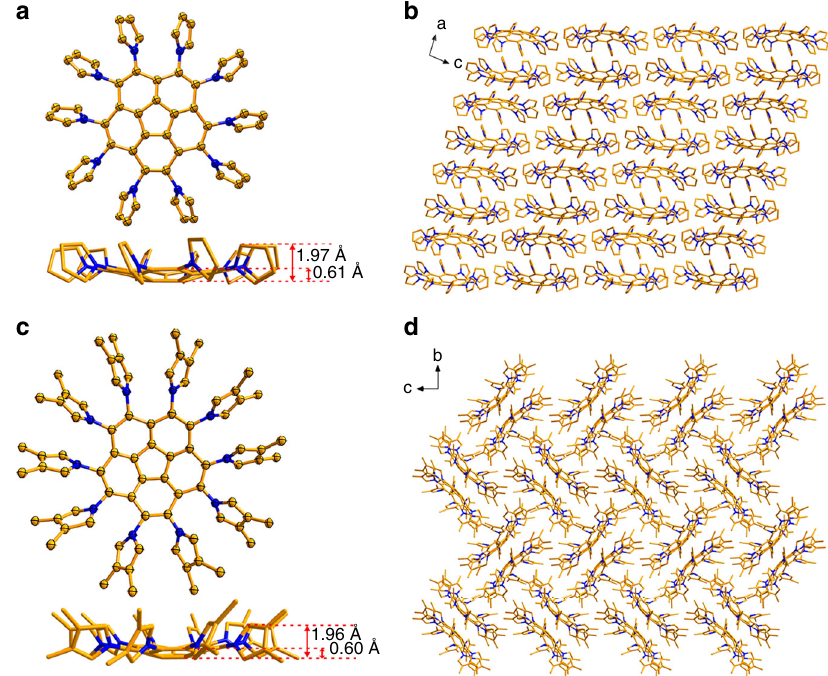
Fig. 2 Crystallographic structures and packing of 2a and 2b . a , c Crystallographic structures of 2a and 2b with thermal ellipsoids at the 50% probability level. The bowl depths of 2a and 2b are indicated. b , d Packing structures of 2a in the a – c plane and 2b in the b – c plane. C atom is shown in gold and N atom in navy blue. All hydrogen atoms are omitted for